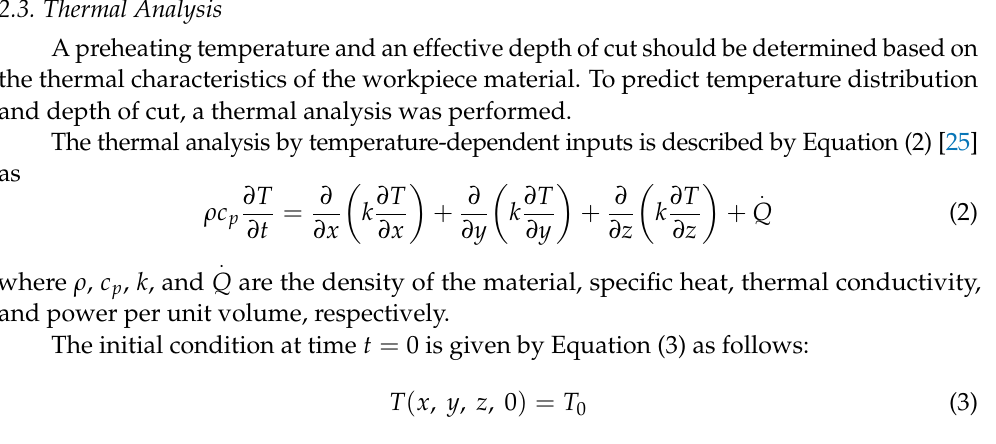
Figure 4. The results of absorptivity versus temperature behavior of the Ti ‐ 6Al ‐ 4V workpiece sample.